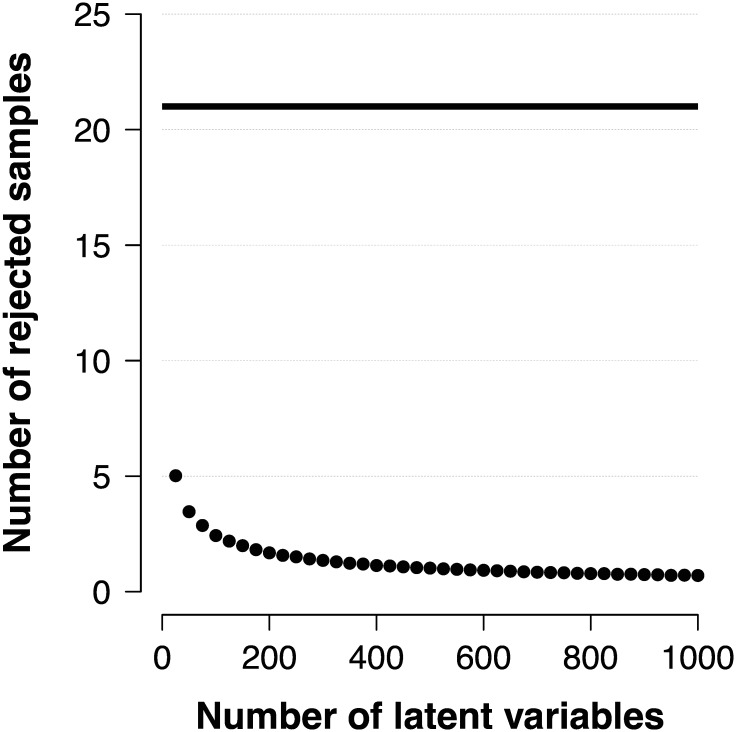
Number of rejected samples for the rejection algorithms.The average number of rejected samples per posterior π(θ ∣ x+) out of n target distributions in the original Rejection algorithm (solid line) and when rejected values are recycled among the target distributions (points).